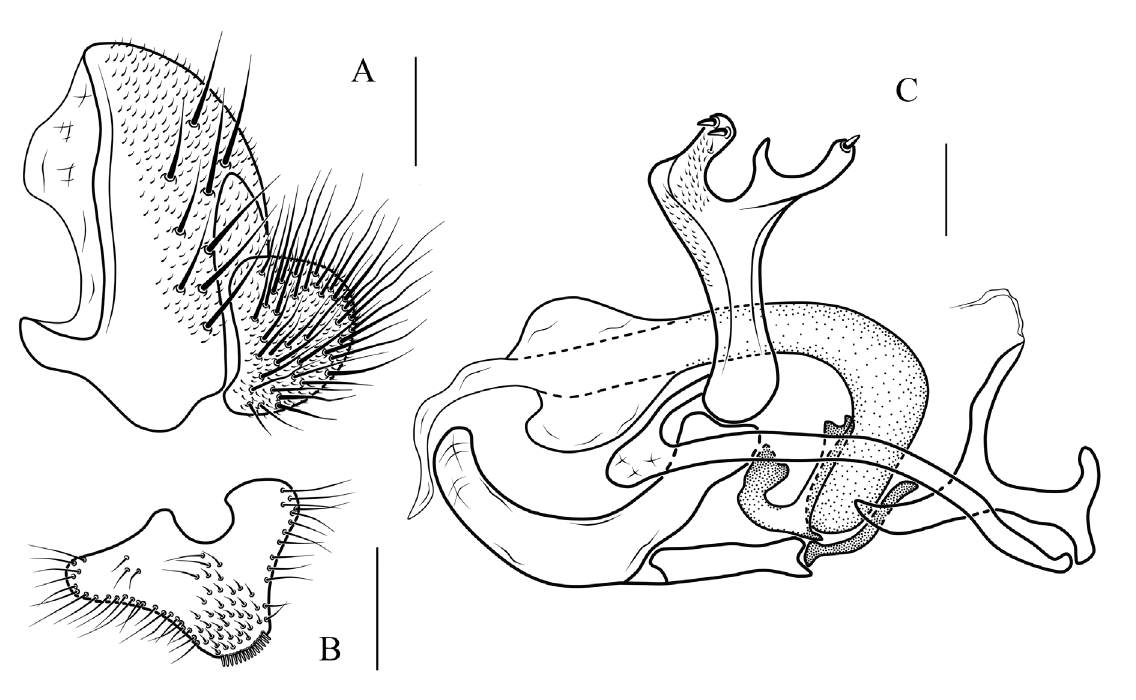
Fig. 5. Phortica ( Phortica ) wongding sp. nov., ♂. A . Epandrium and cercus; B . Surstylus; C . Hypandrium, paramere, aedeagus and aedeagal apodeme. Scale bars =